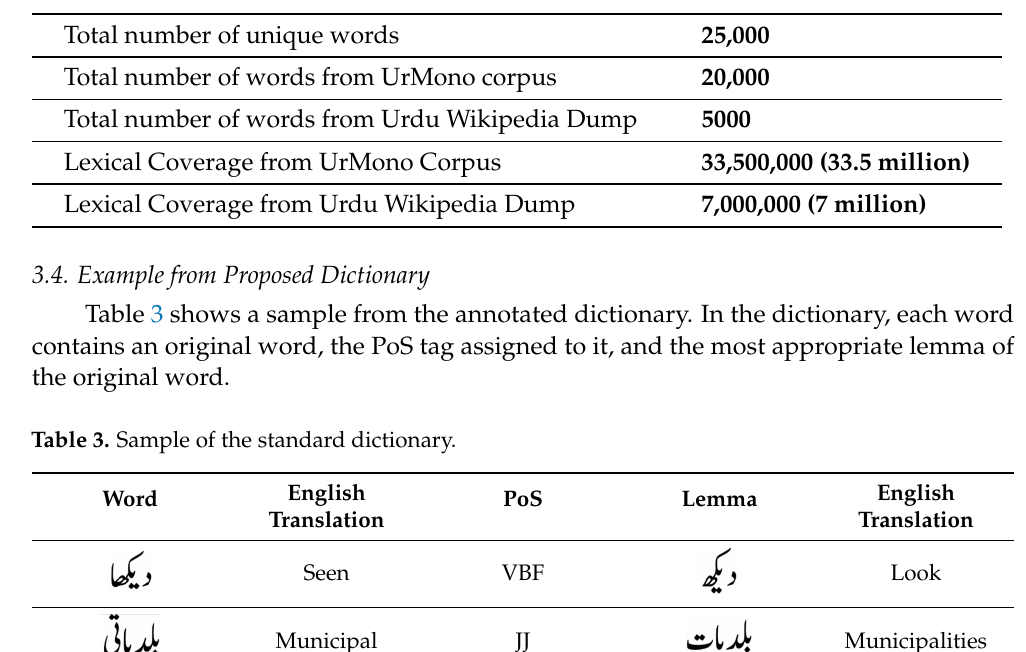
Table 2. Detailed statistics of the dictionary.